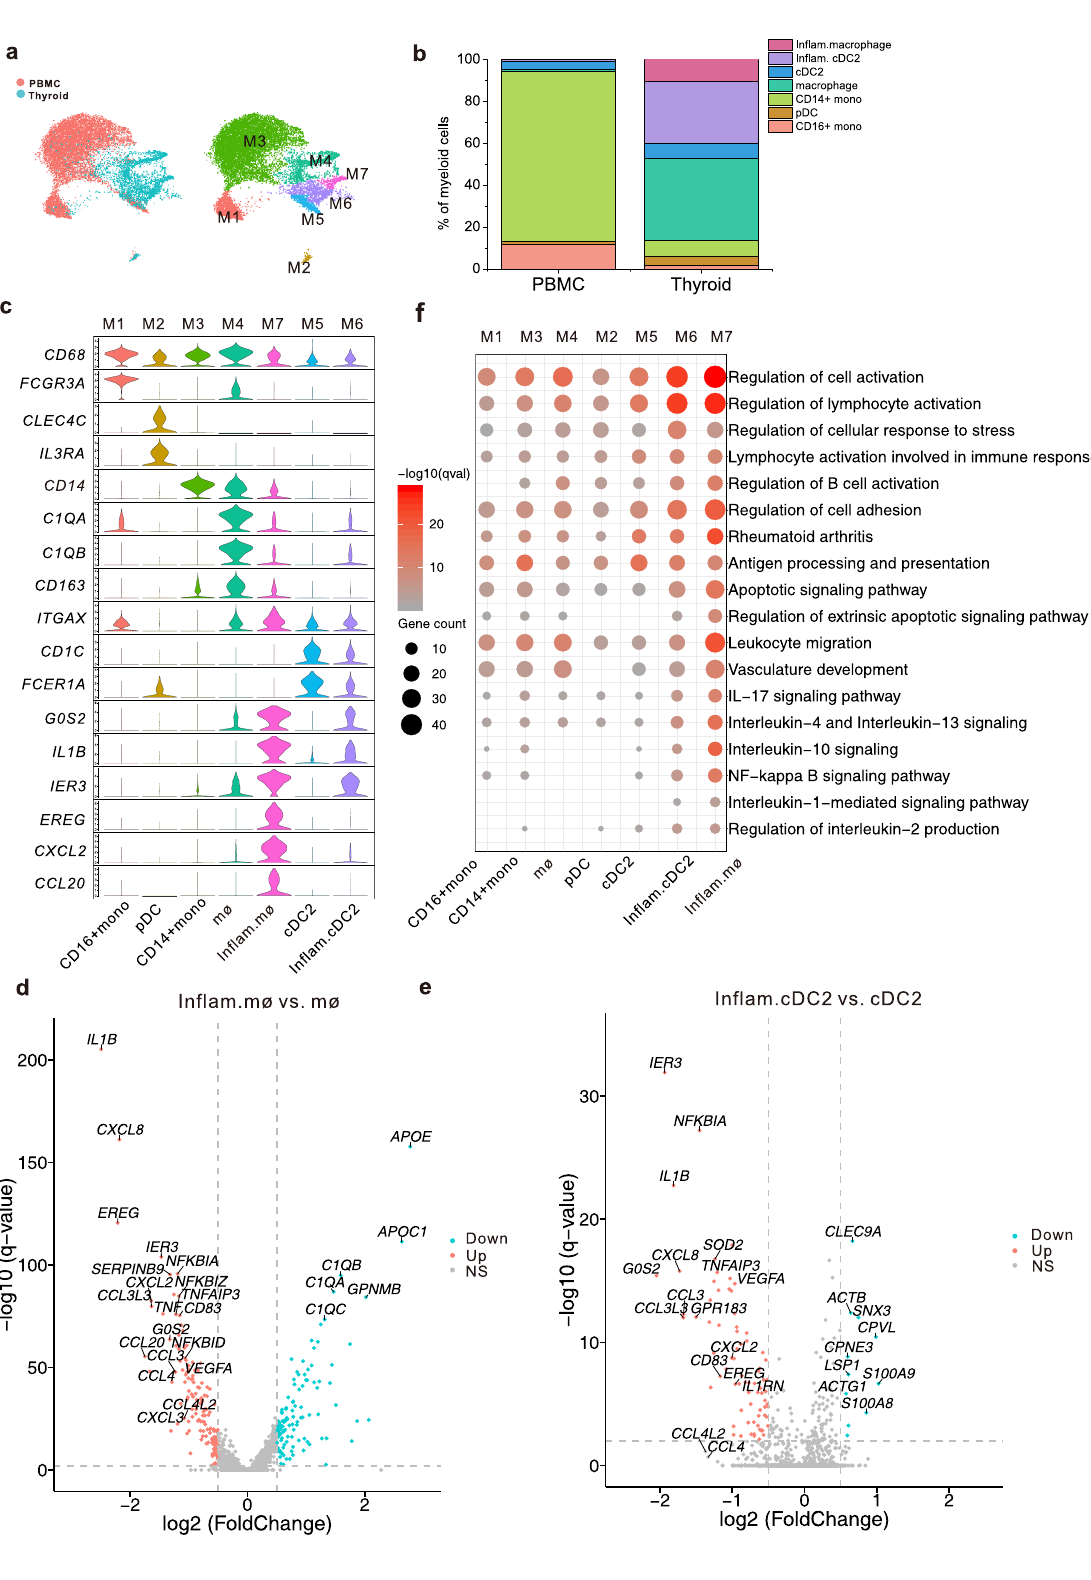
de fi ned M6 and M7 as in fl ammatory cDC2 (in fl am.cDC2) and in fl ammatory macrophages (in fl am. mø),